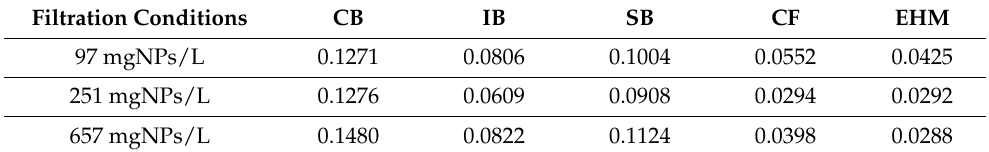
Table 17. RMSE results obtained in Example 6 at 0.4 bar and different nanoparticle